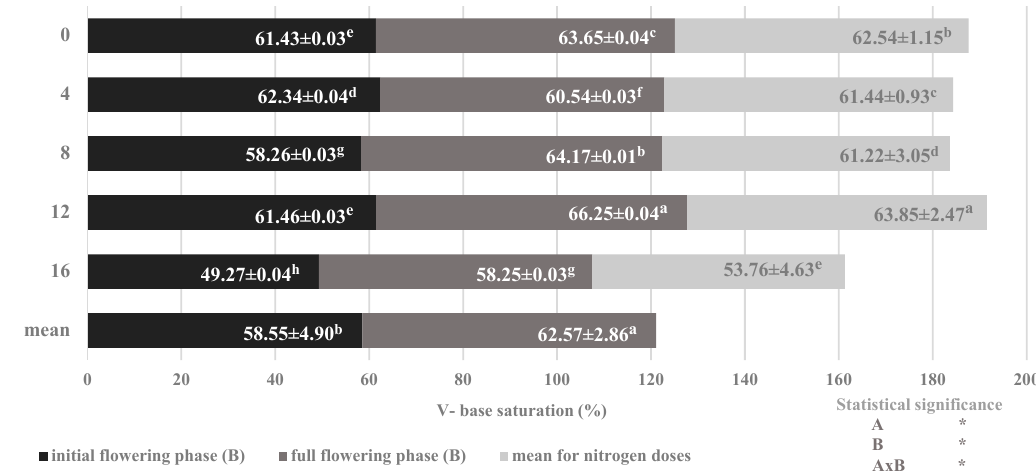
Figure 5. Degree of saturation of soil with basic cations depending on nitrogen nutrition and development phases of savory plants (mean for 2014–2016) (Note: The results are presented as the mean ± SD; Means sharing the same letter on a bars do not di ff er significantly according to Tukey’s test at p ≤ 0.05; significant e ff ects for the main factors and for interaction between them are indicated with asterisks (*); n.s.—no